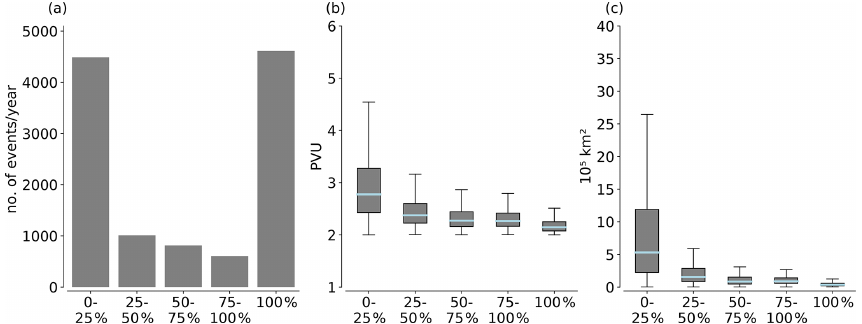
Figure 6. (a) Histogram of the percentage of air parcels in a PV cutoff experiencing decay whenever the PV cutoffs disappear on an individual isentrope (average annual number of events, 0% corresponds to pure reabsorption, 100% to complete diabatic decay), and (b, c) standard box plots (outliers not shown) of (b) mean PV and (c) area of the PV cutoff at the isentropic level from which it disappears for the histogram classes in (a)